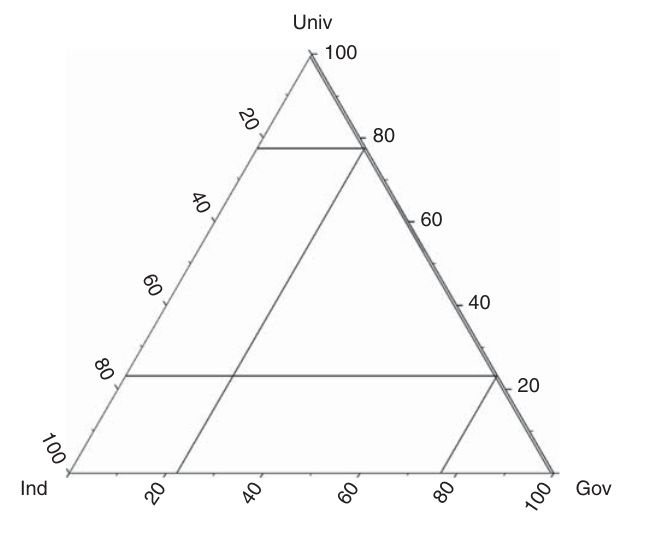
Figure 4. Core of Nigeria